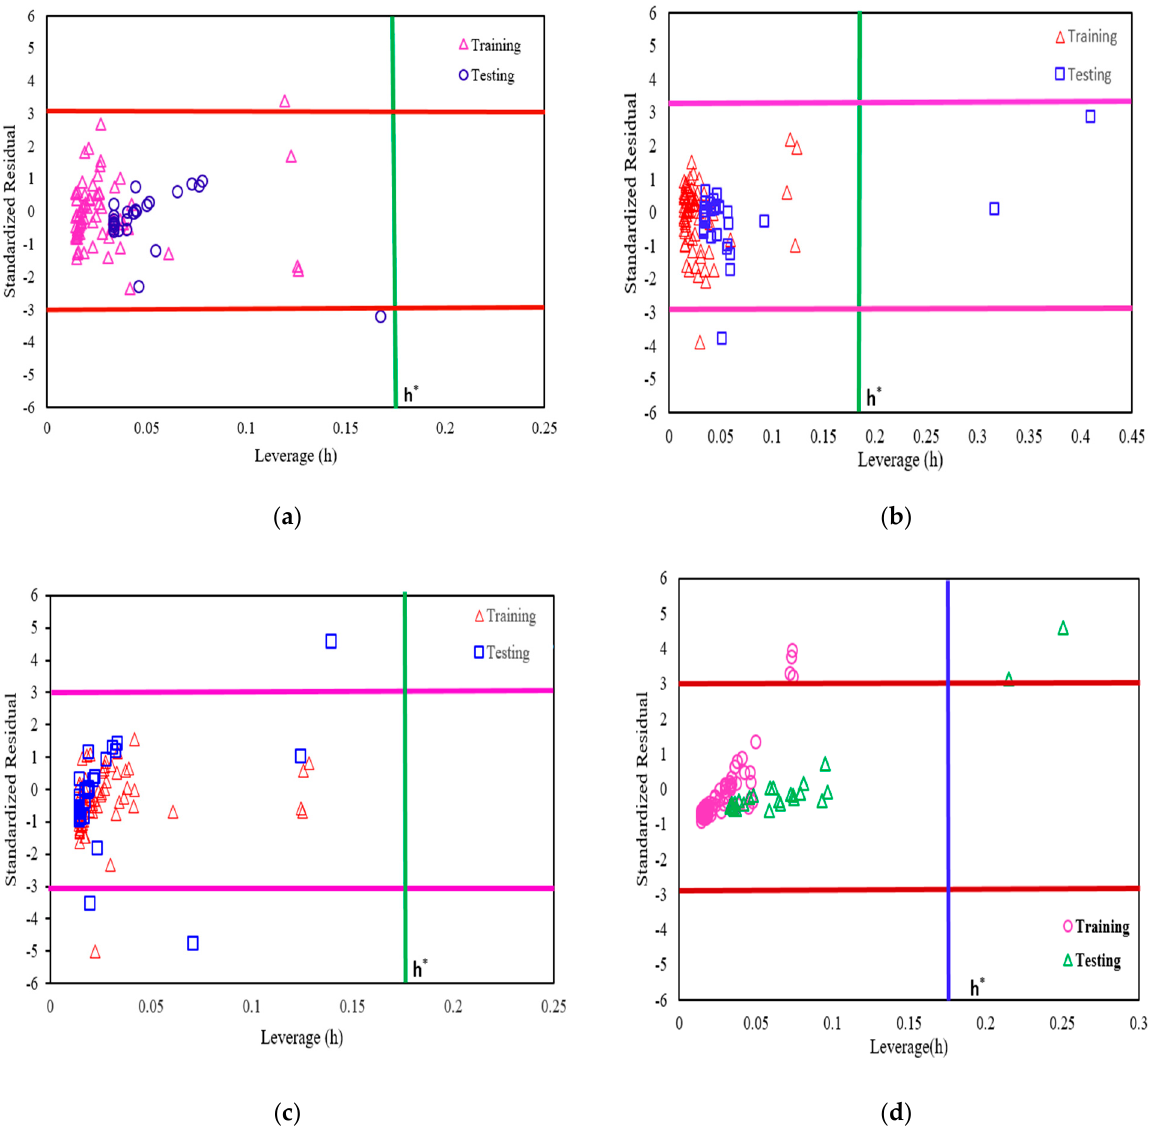
Figure 8. Williams plot for hybrid ANFIS model: ( a ) ANFIS − PSO, ( b ) ANFIS − FFA, ( c ) ANFIS − GA and ( d ) ANFIS − GWO.